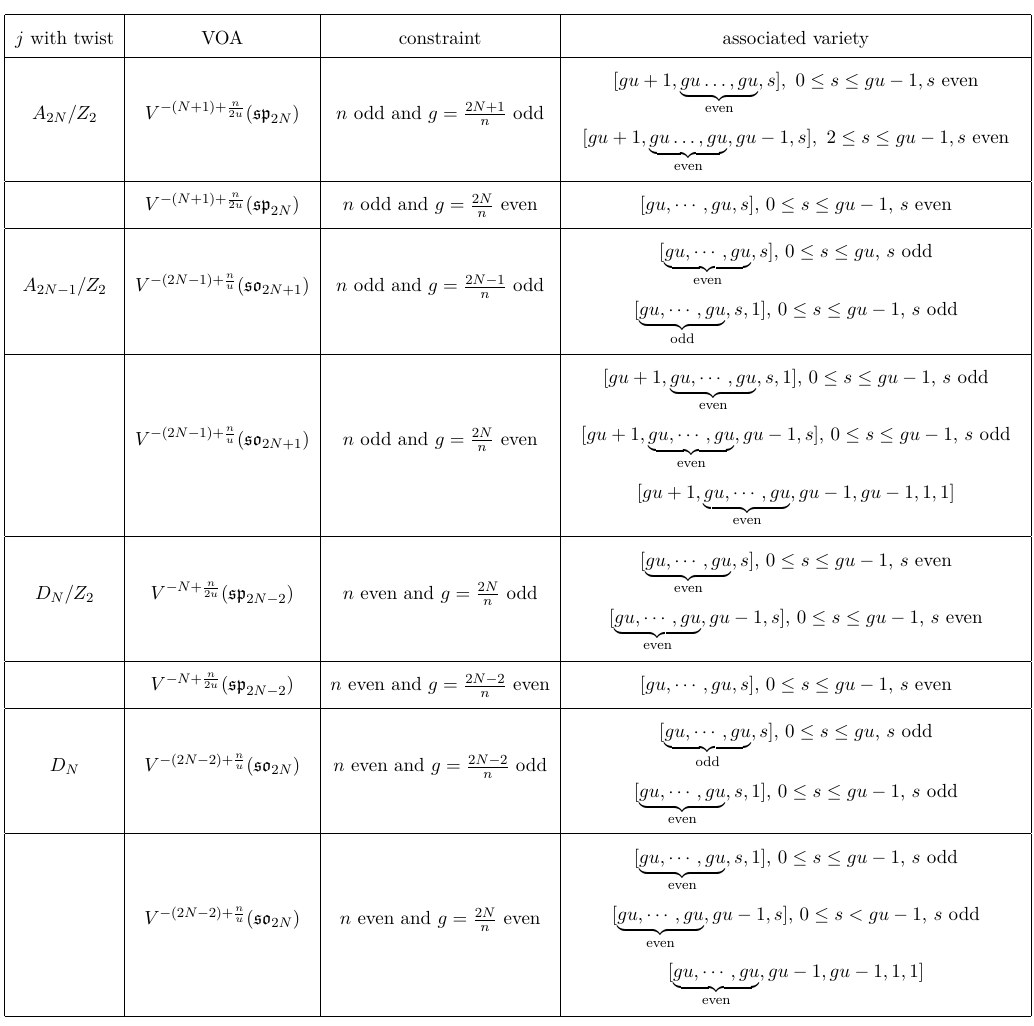
Table 15 . The associated variety of non-admissible lisse W-algebra defined using classical Lie algebra. u is coprime with n , and u is always odd. The associated variety is the closure of the nilpotent orbit of Lie algebra used to define